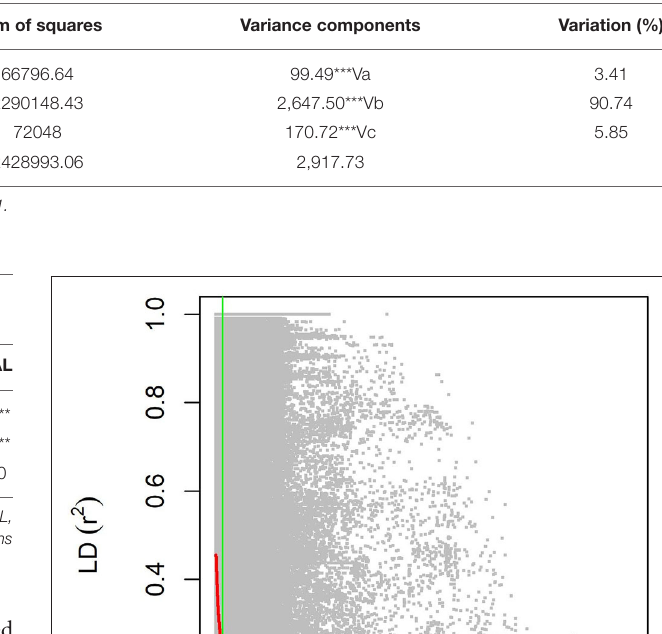
TABLE 3 | Results from analysis of molecular variance (AMOVA). Source of variation